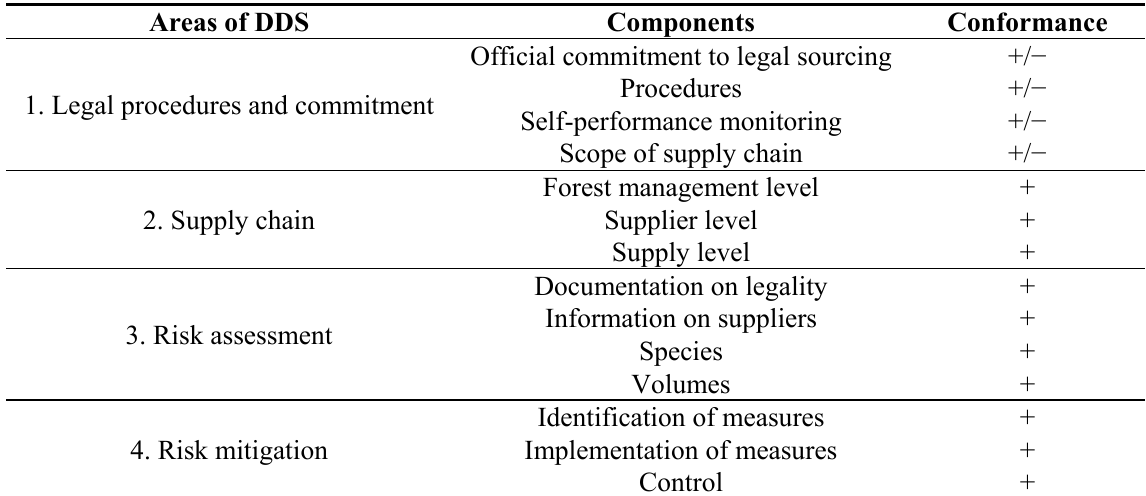
Table 10. Conformance of the company’s DDS with the EUTR